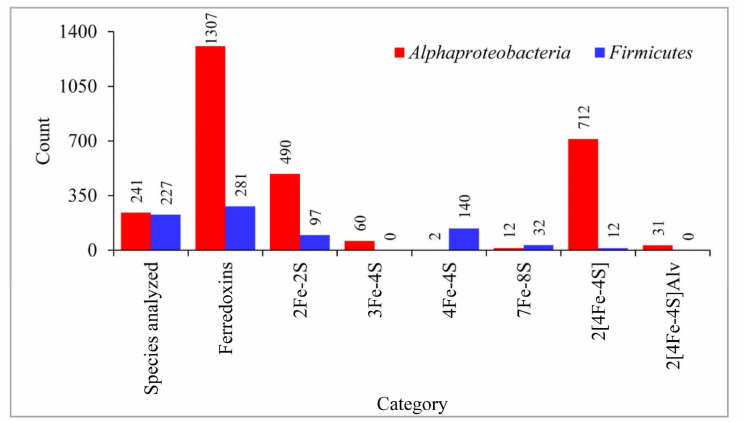
Figure 2. Comparative analysis of ferredoxins iron-sulfur (Fe-S) cluster features between alphapro- teobacterial species and Firmicutes species. The number next to the bar indicates the count for that category. Detailed information on species and their ferredoxins is presented in Table